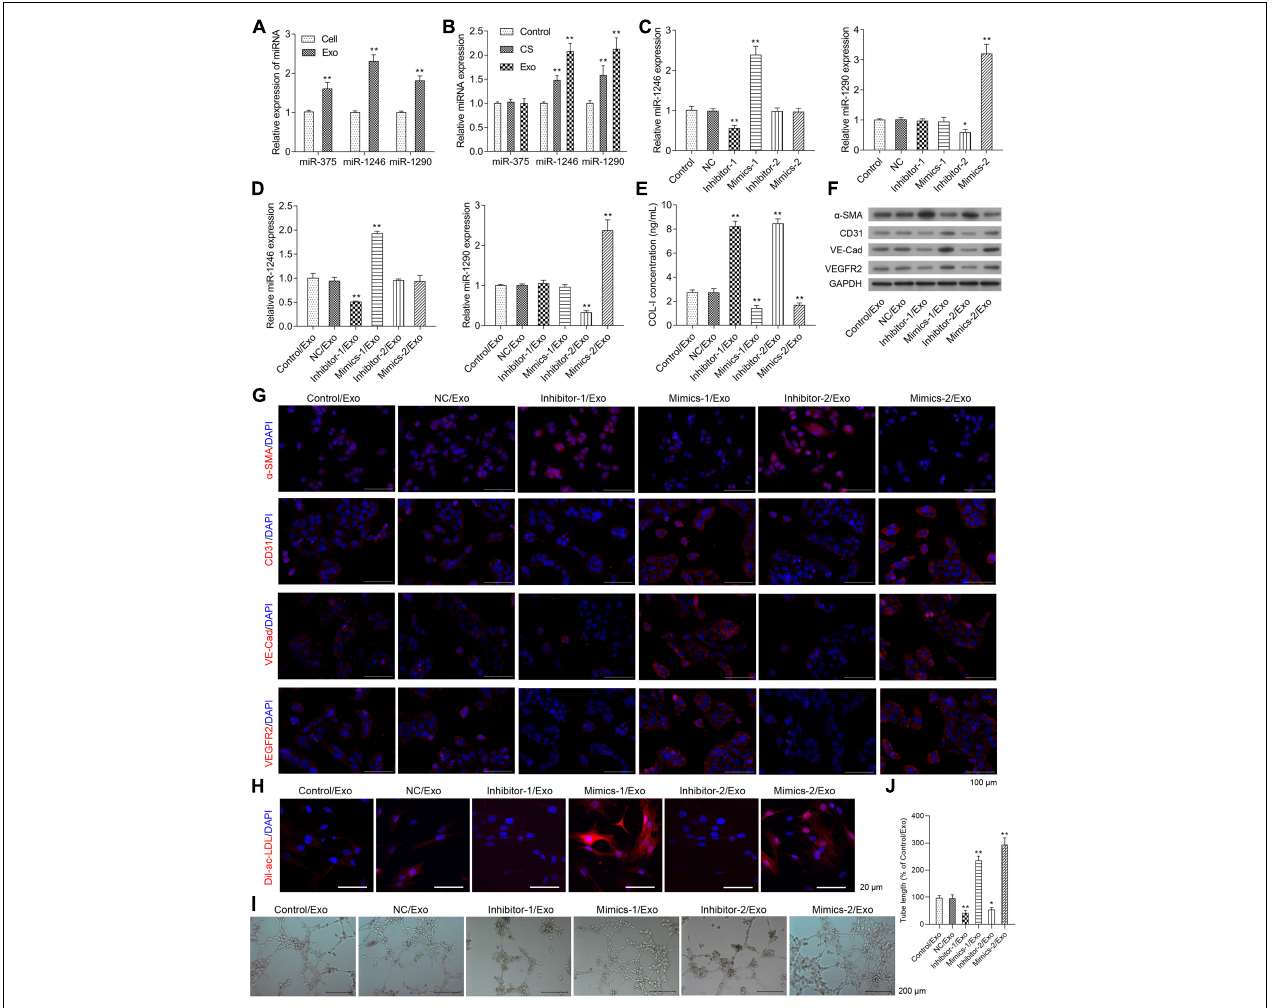
FIGURE 3 | Effects of miR-1246 and miR-1290 on angiogenesis induced by exosomes from EPCs. The miR-375, miR-1246, and miR-1290 levels in exosomes itself or in whole EPCs were determined via real-time PCR (A) . After treatment with control, CS, or Exo, HCFs were harvested to determine the expressions of miR-375, miR-1246, and miR-1290 (B) . The EPCs received one of the following transfections: miR-1246 inhibitor-1, miR-1246 mimics-1, miR-1290 inhibitor-2, Mimics-2, and NCs. Then, the expressions of miR-1246 and miR-1290 in exosomes derived from the parent or transfected EPCs were determined (C) . HCFs were treated with exosomes from parent EPCs (Con/Exo), exosomes from EPCs transfected with NC (NC/Exo), miR-1246 inhibitor-1 (inhibitor-1/Exo), miR-1246 mimics-1 (Mimics-1/Exo), miR-1290 inhibitor-2 (inhibitor-2/Exo), or miR-1290 mimics-2 (Mimics-2/Exo). Then, the cells were collected, expressions of miR-1246 and miR-1290 were determined by qRT-PCR (D) , the level of Collagen-I (Col-I) in the medium was determined by ELISA (E) , and the expressions of α -SMA, CD31, VE-Cad, and VEGFR2 were determined by western blot (F) and immunofluorescence staining (G) . Additionally, the phagocytic activity of HCFs was determined by DiL-Ac-LDL staining (H) , and the angiogenesis was measured by a method of tube formation assay (I) . The tube length in each group was quantified according to the results of tube formation assay (J) . The cells were treated with exosomes (4 µ g/ml) of EPCs for 24 h. N = 3. * P < 0.05, ** P < 0.01 vs. NC/Exo group. Exo, exosomes; Mimics-1, miR-1246 mimics; Mimics-2, miR-1290 mimics; Inhibitor-1, miR-1246 inhibitor; Inhibitor-2, miR-1290